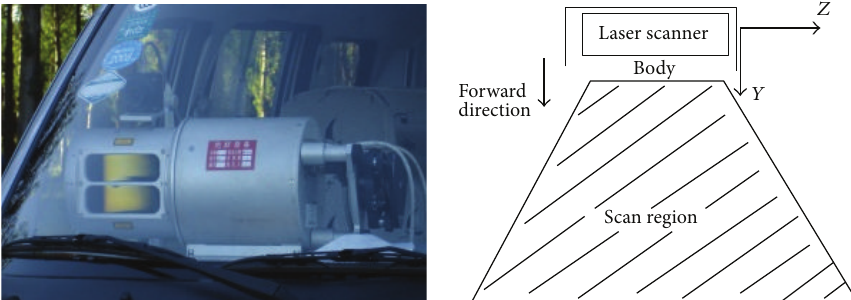
Figure 7: 3D LIDAR and unmanned ground